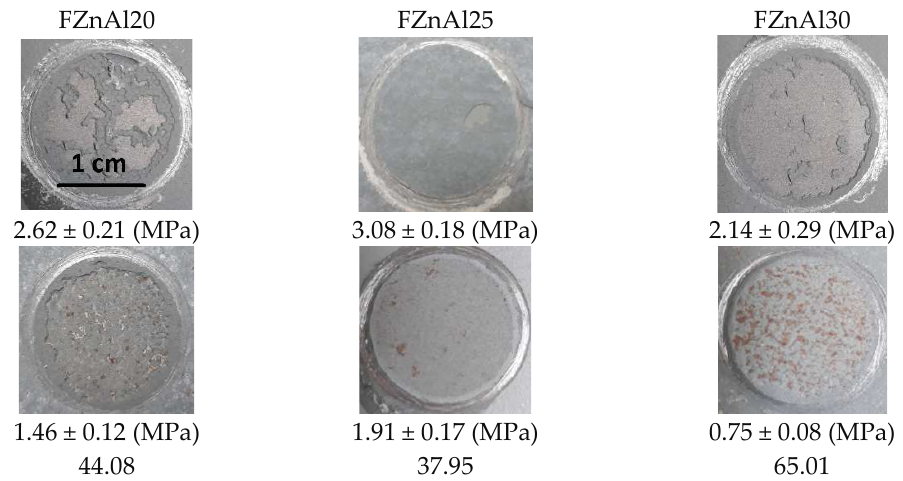
Figure 7. Surface images and adhesion of silicate coatings before and after the salt spray test for 1000 h.